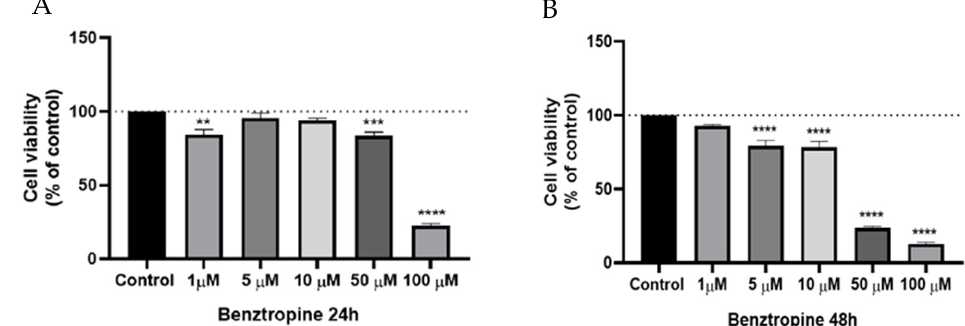
Figure 14. Effect of benztropine over 24 h ( A ) and 48 h ( B ) on the cell viability (% of control) of MCF-7 cells, based on three independent experiments ( n = 3). Results are expressed as mean ± standard error of the mean (SEM). ** p < 0.01, *** p < 0.001, **** p < 0.0001.